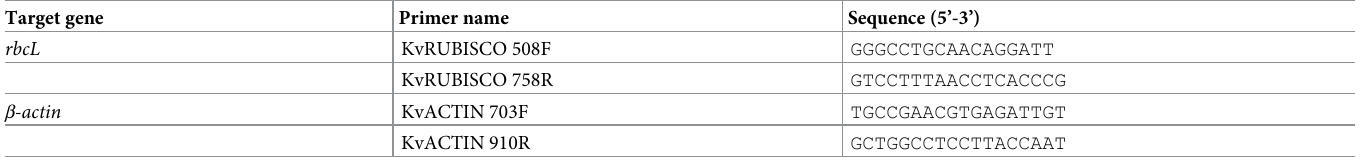
Table 1. PCR primer sequences designed K . veneficum